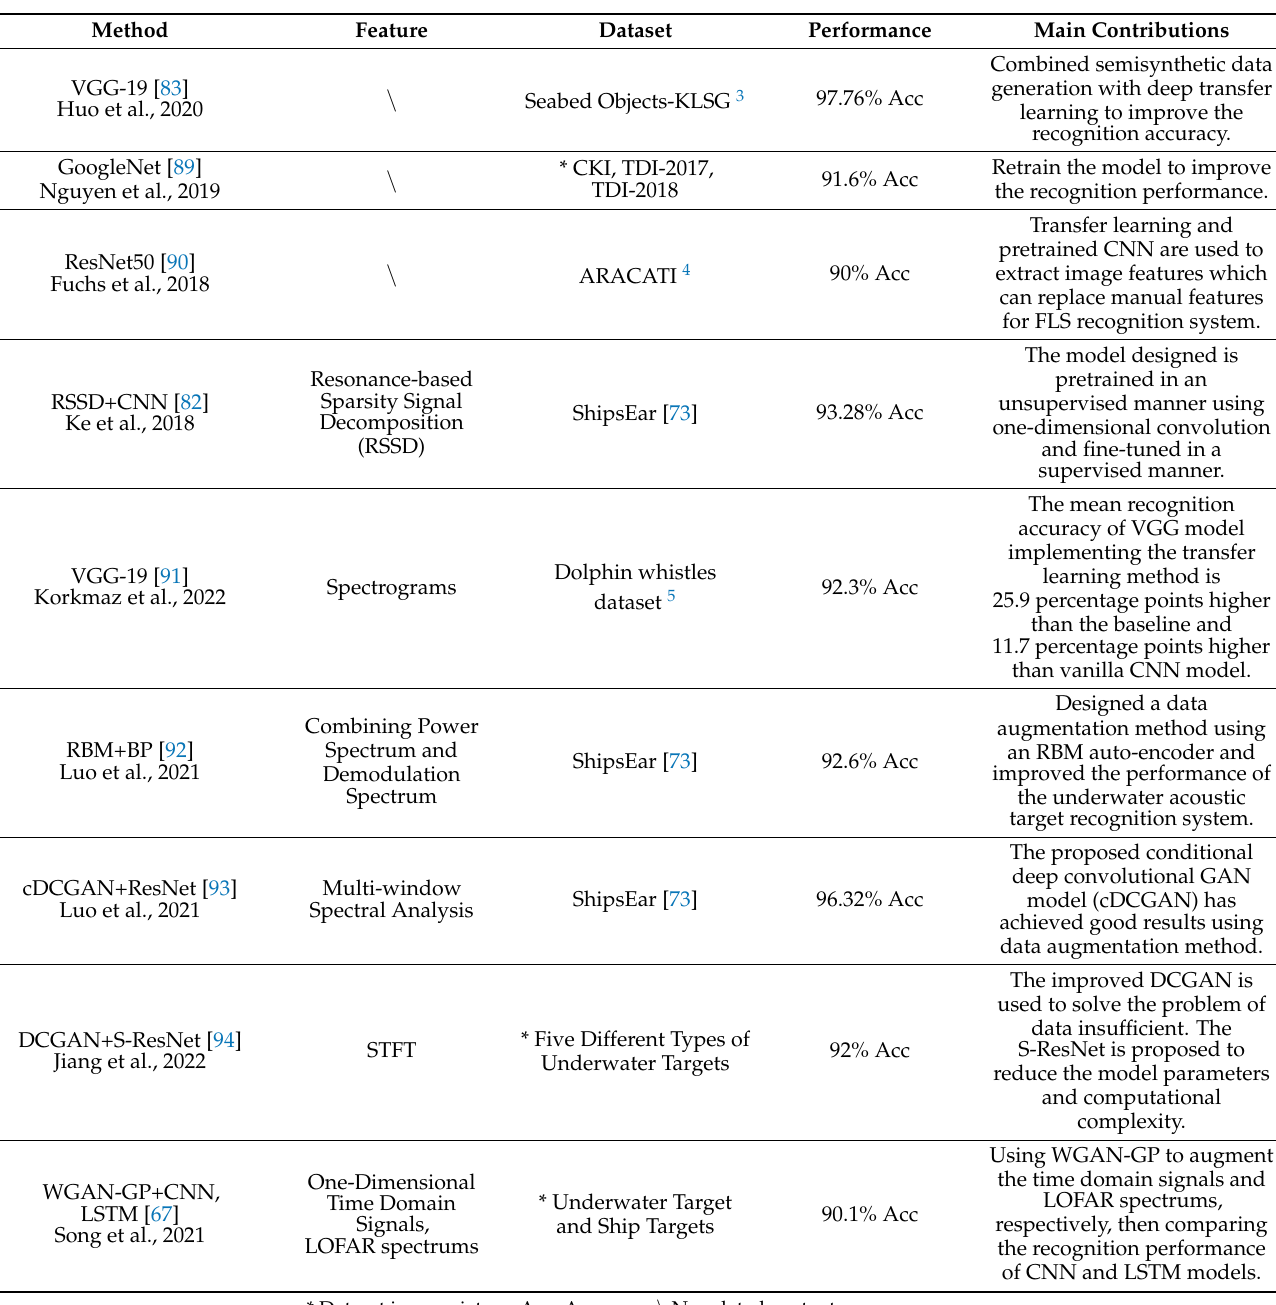
Table 3. An overview of transfer learning and data augmentation strategies for